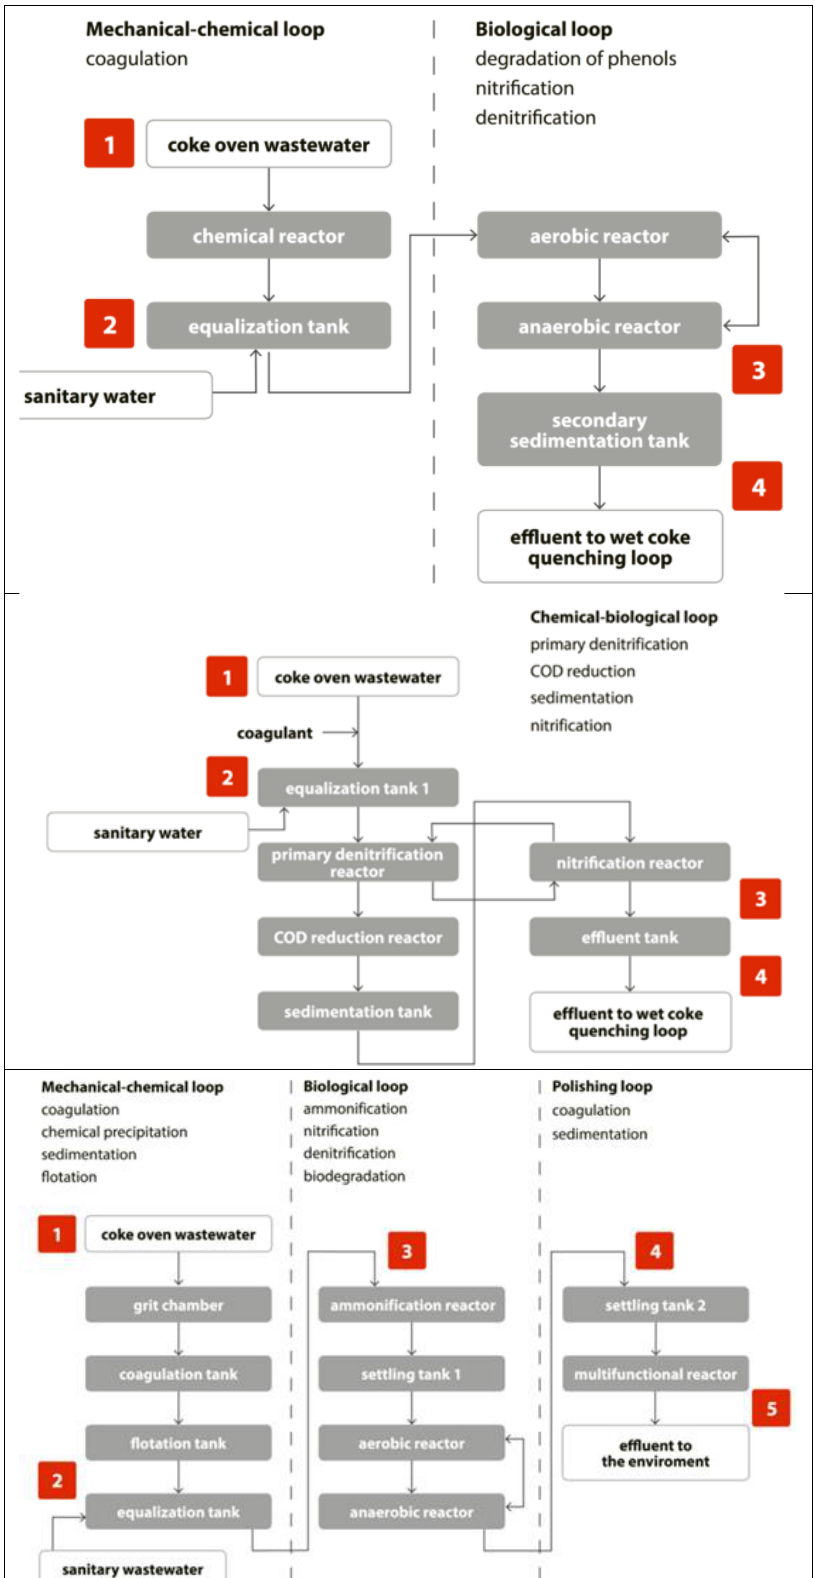
Figure 3. Different arrangements of coke oven wastewater treatment plants Figure 3: Different arrangements of coke oven wastewater treatment